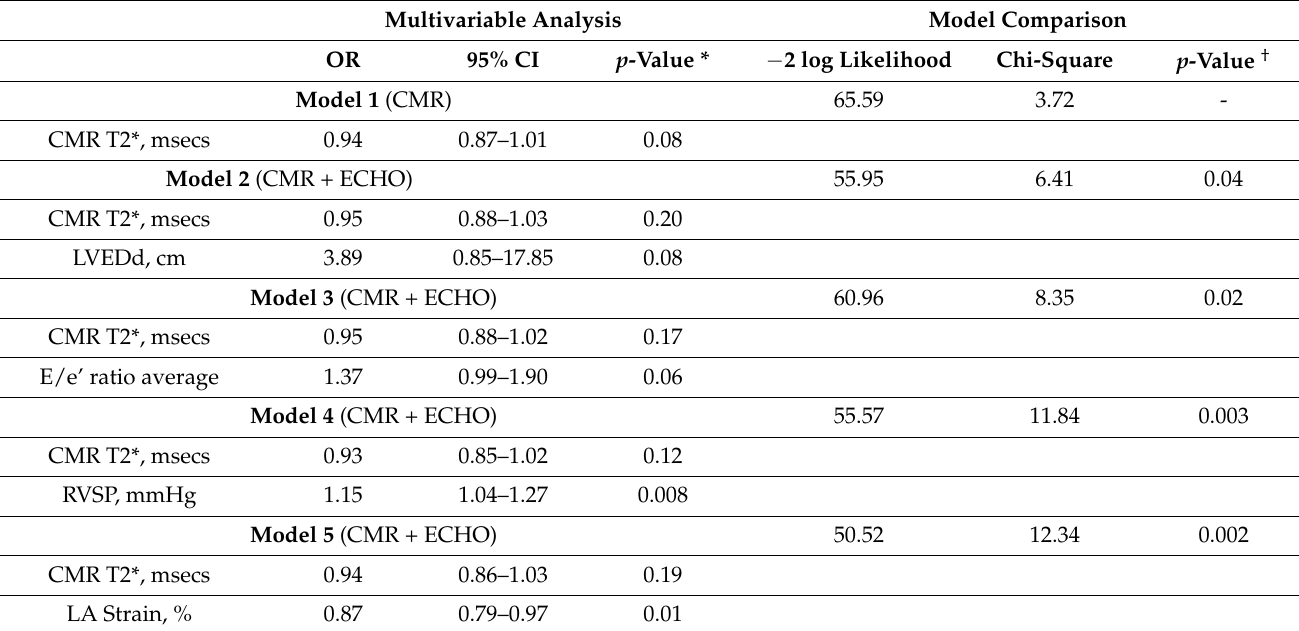
Table 6. Multivariable models of cardiac magnetic resonance T2* and echocardiography associates of premature atrial contractions > 24/day in β -thalassemia-major